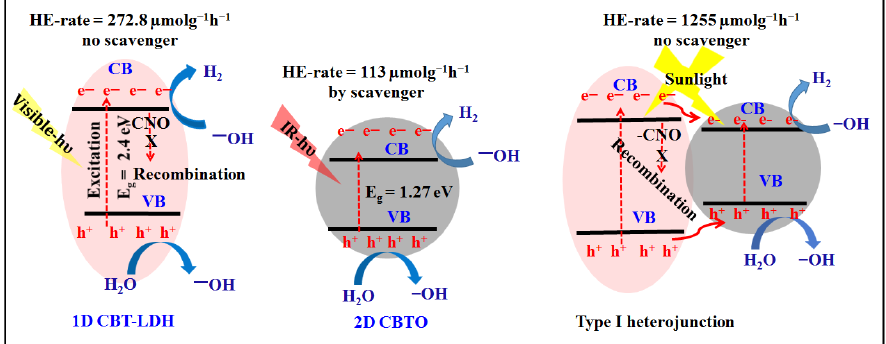
Figure 11. The role of 1D CBTO LDH in enhancing the HER of CBT-LDH by five-fold under IR- irradiation [127]. Copyright 2022, reproduced with permission from Elsevier.